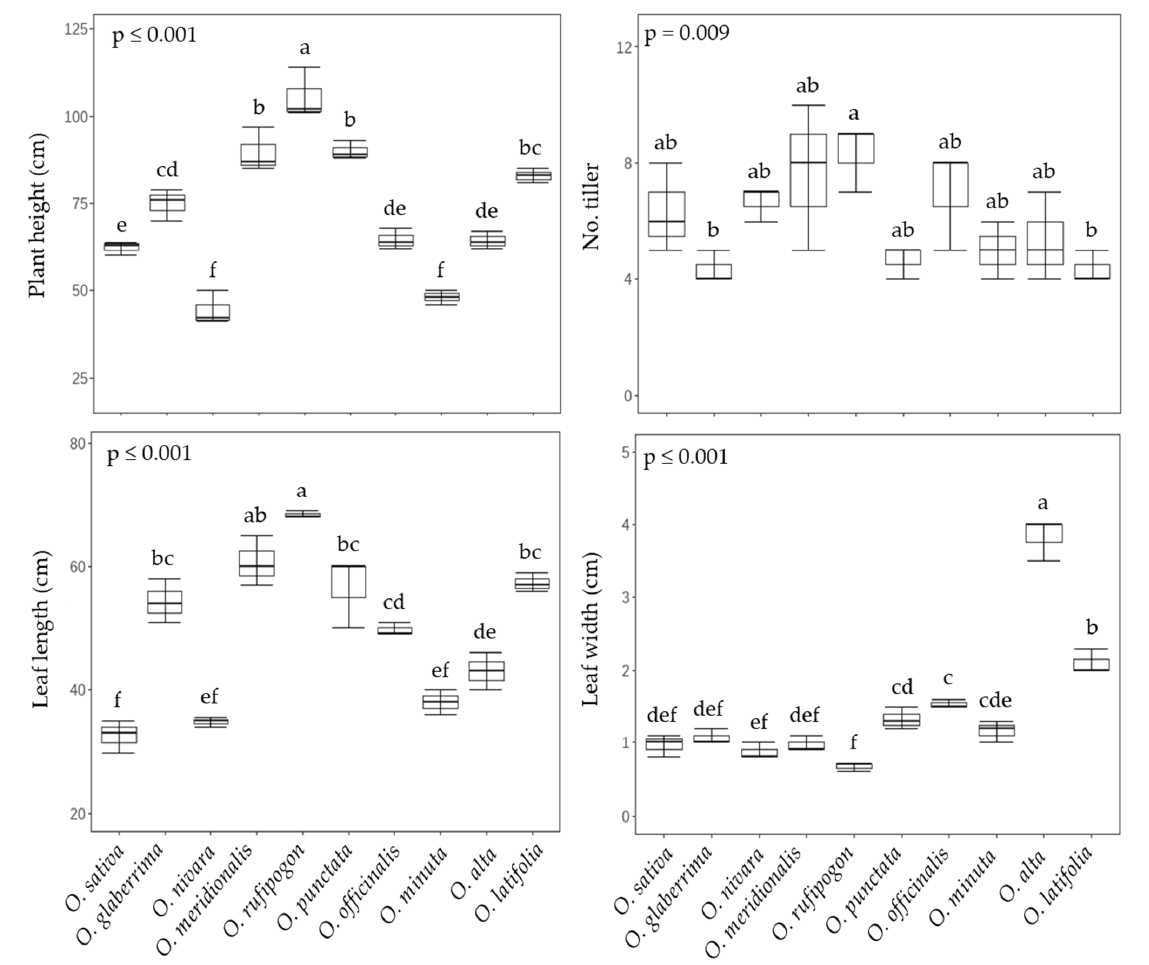
Figure 2. Comparison of vegetative agronomic traits between rice species at 60 DAT (mean of three replications ± S.D.). Means followed by different letters in the same raw are significantly different at p < 0.05 according to Turkey’s HSD test.